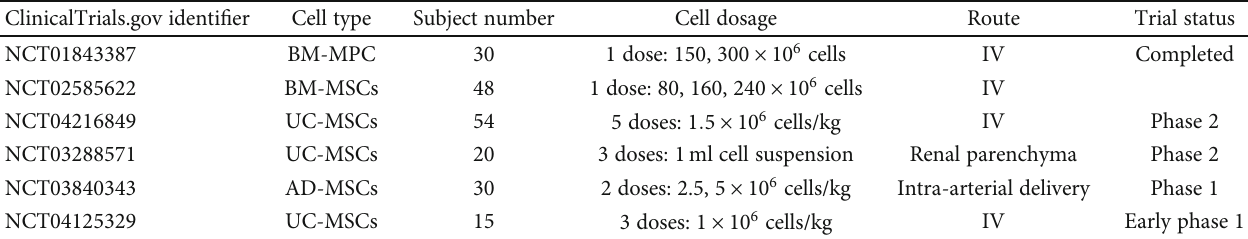
Table 2: Ongoing or completed clinical trials with MSC-based therapy in DN. ClinicalTrials.gov identi fi